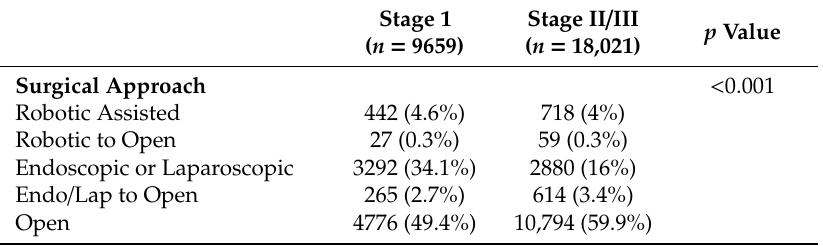
Table 3. Surgical Approach Examined for Stages I and II / III from 2010 to 2016, n =